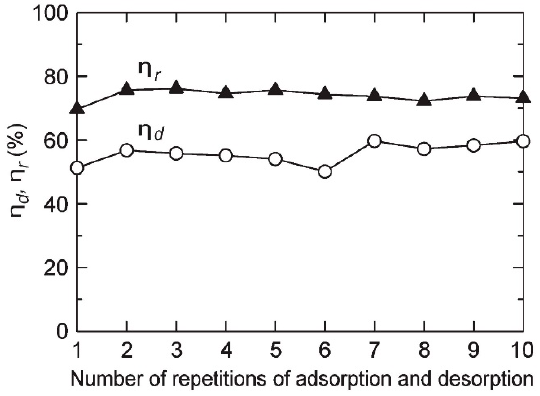
Figure 12. Desorption and regeneration efficiencies denoted by η d and η r , respectively, as a function of repetitive operation. Reprinted from Ref. [84], with permission from